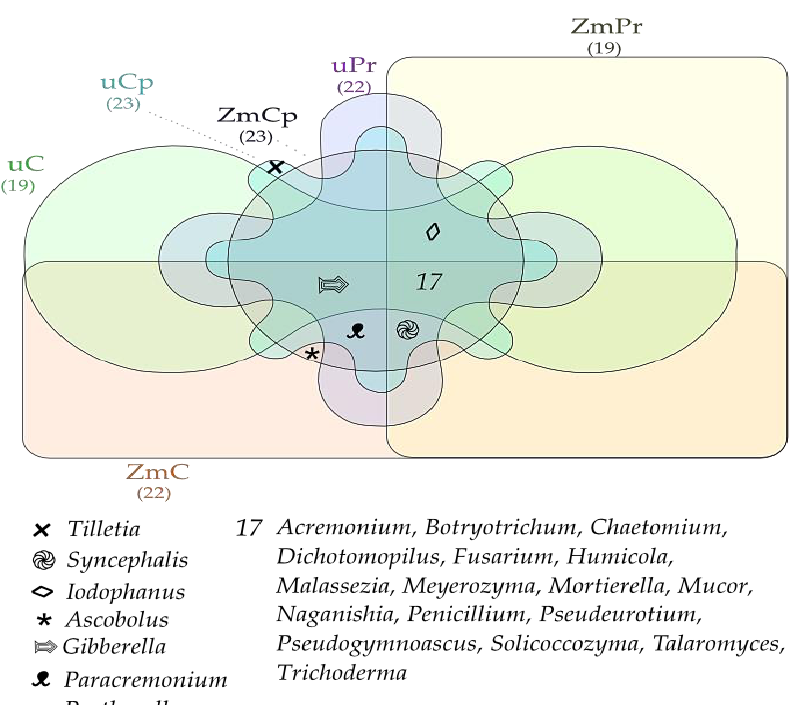
Figure 11. Venn diagram showing common and unique types of fungi in the soil. uC — contaminated unsown soil; uPr — sown soil contaminated with permethrin; uCp — sown soil contaminated with cypermethrin; ZmC — uncontaminated soil sown with Zea mays ; ZmPr — soil sown with Zea mays contaminated with permethrin; ZmCp — soil sown with Zea mays contaminated with cypermethrin.